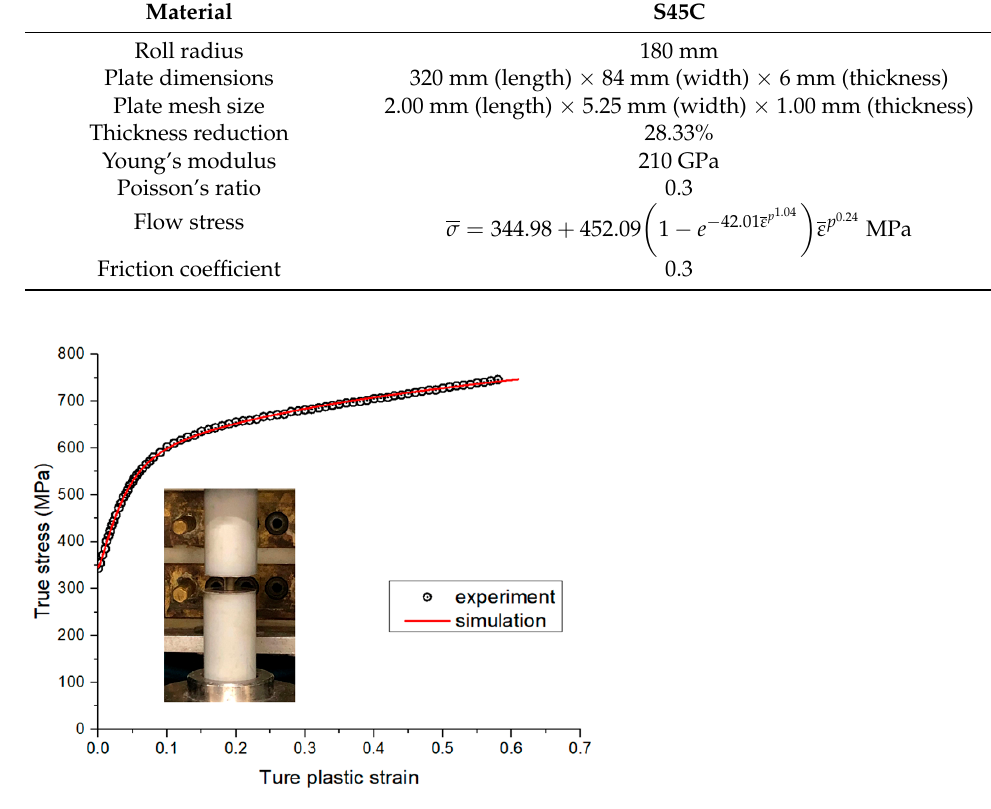
Figure 7. Experimental and simulation flow stress of the S45C plate obtained using the compression test.